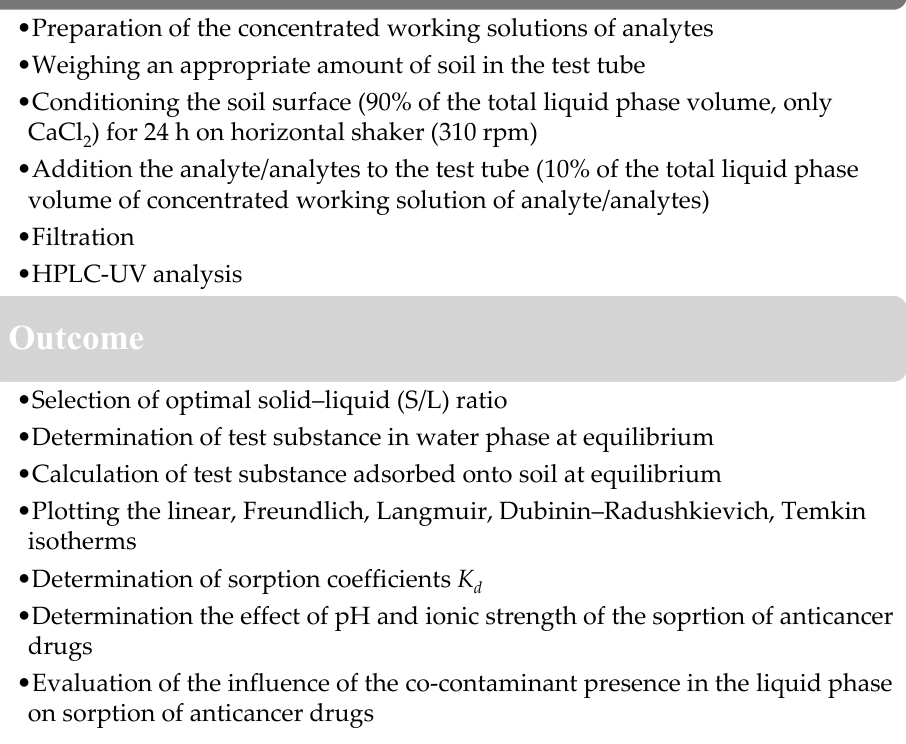
Figure 6. Conceptual approach of the research presented in this study .